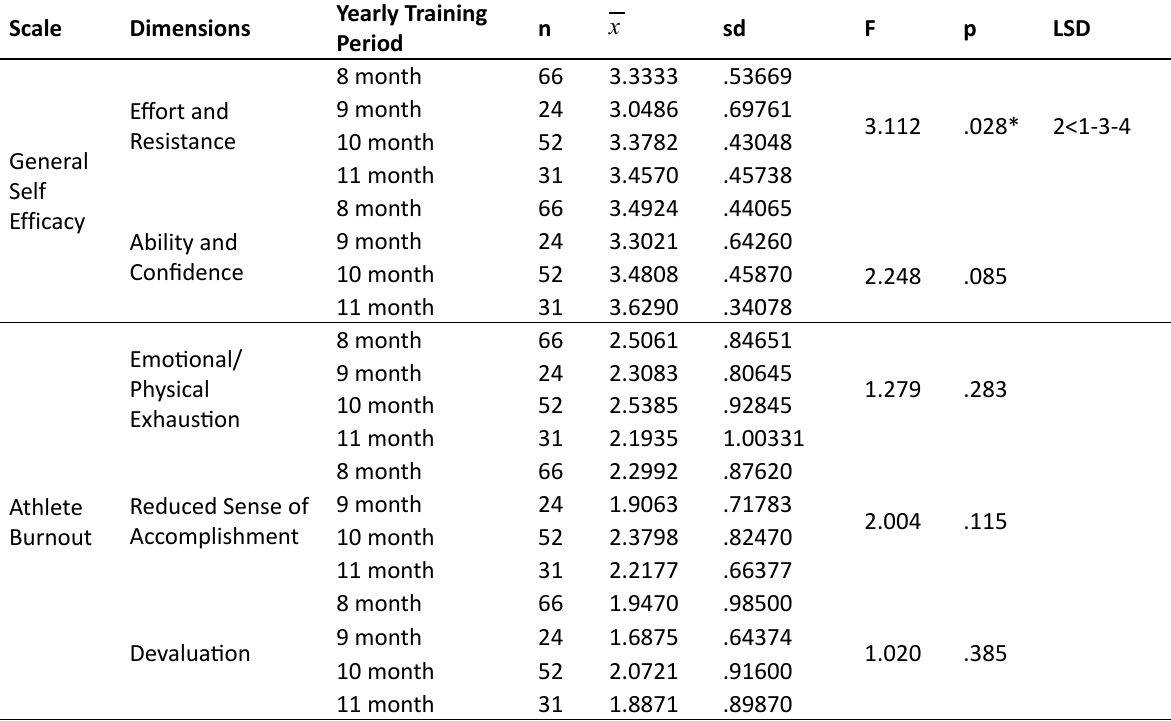
Table 7. Evaluation of general self-efficacy and athlete burnout level by yearly training period Scale